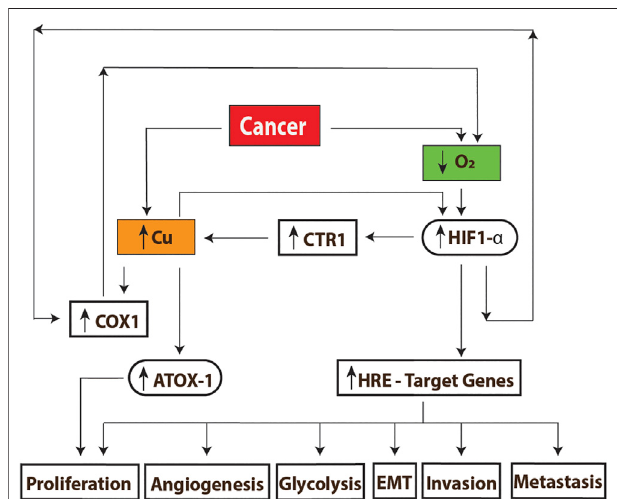
FIGURE5| Mechanismsofcopperactionincancer. (A) Thehighenergy demandfoundinthesecellsdecreasestheoxygenconcentrations,producing hypoxia; this causes an increase in the transmembrane transporter CTR1, which causes an increase of the intracellular concentrations of copper. Thelevelsofthismetaltogetherwiththereducedconcentrationofoxygencan stabilize and activate the HIF-1 transcription factor, triggering the activation of genes related to growth and tumor development. On the other hand, the high copper content promotes the assembly of complex IV (COX1) which is followedbytheupregulationofOXPHOS.Ahigheroxygendemandwillinduce the upregulation of HIF1-alpha, creating a virtuous cycle for tumor growth. Excess of copper will also up regulate ATOX1 expression to promote cell proliferation as well. HRE: hypoxia-response Element. EMT: epithelial – mesenchymal